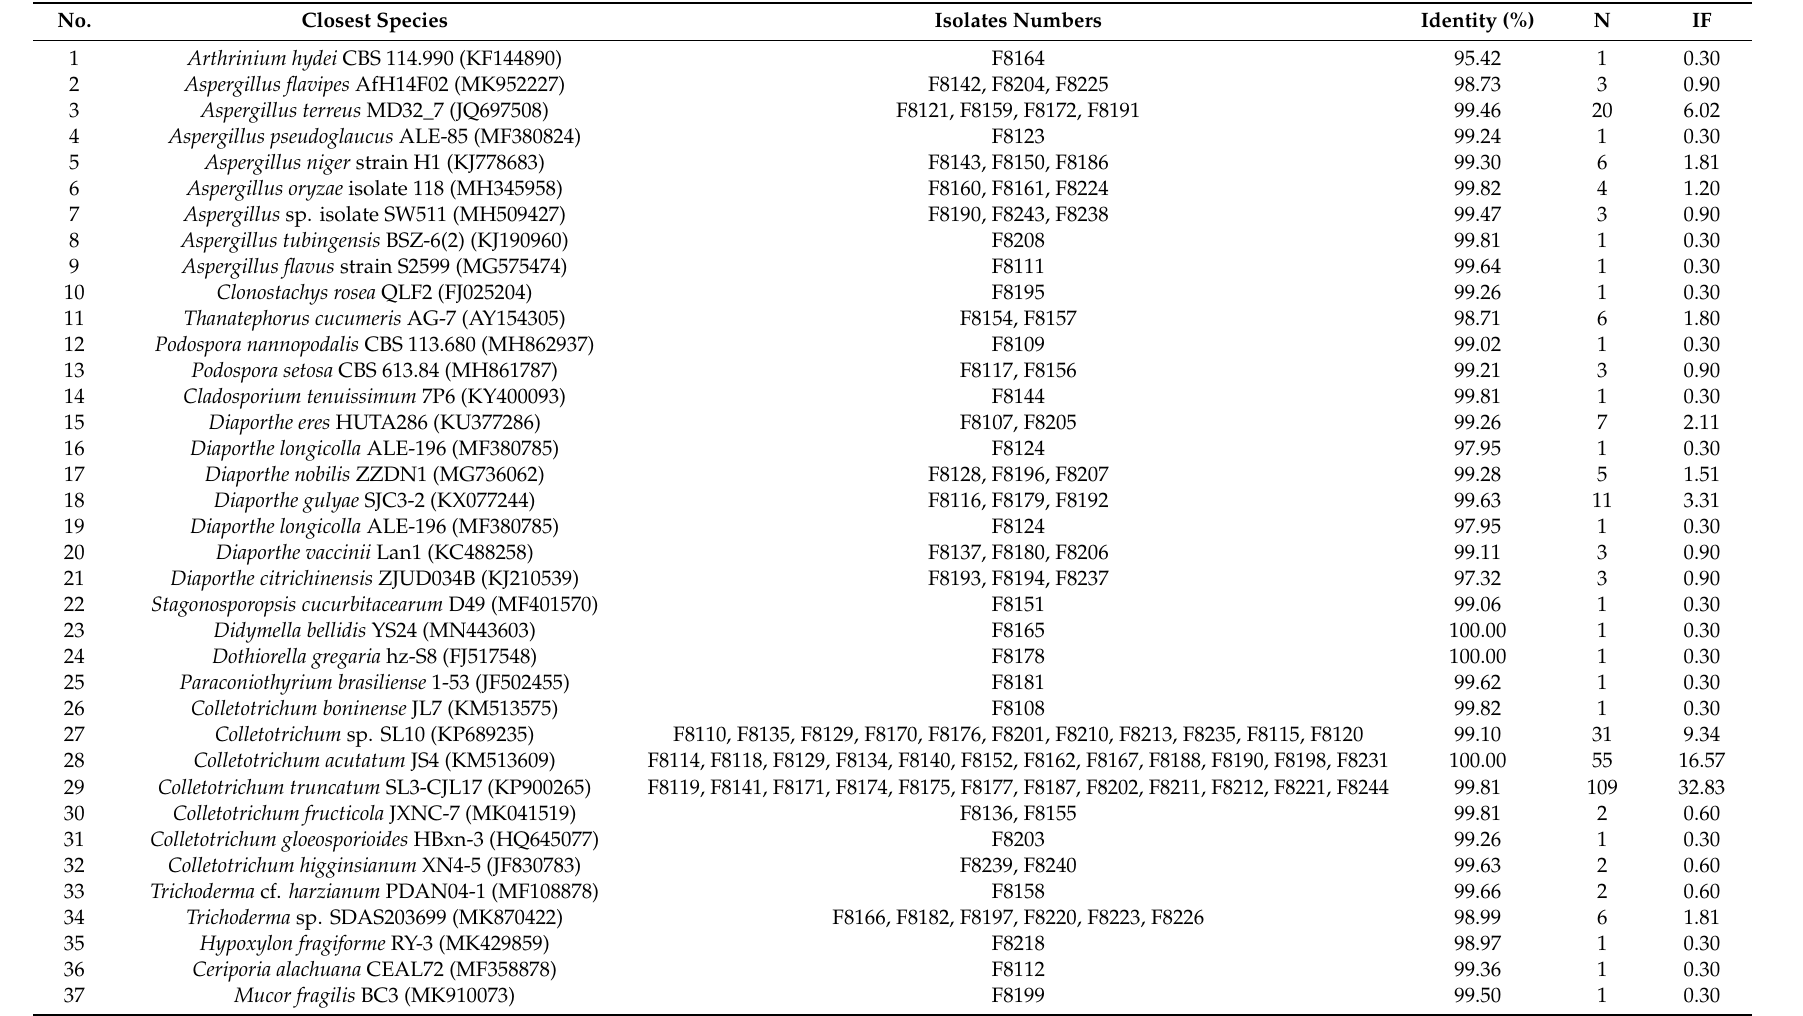
Table 1. Identification of endophytic fungi from C. japonicus by the Basic Local Alignment Search Tool (BLAST) in the